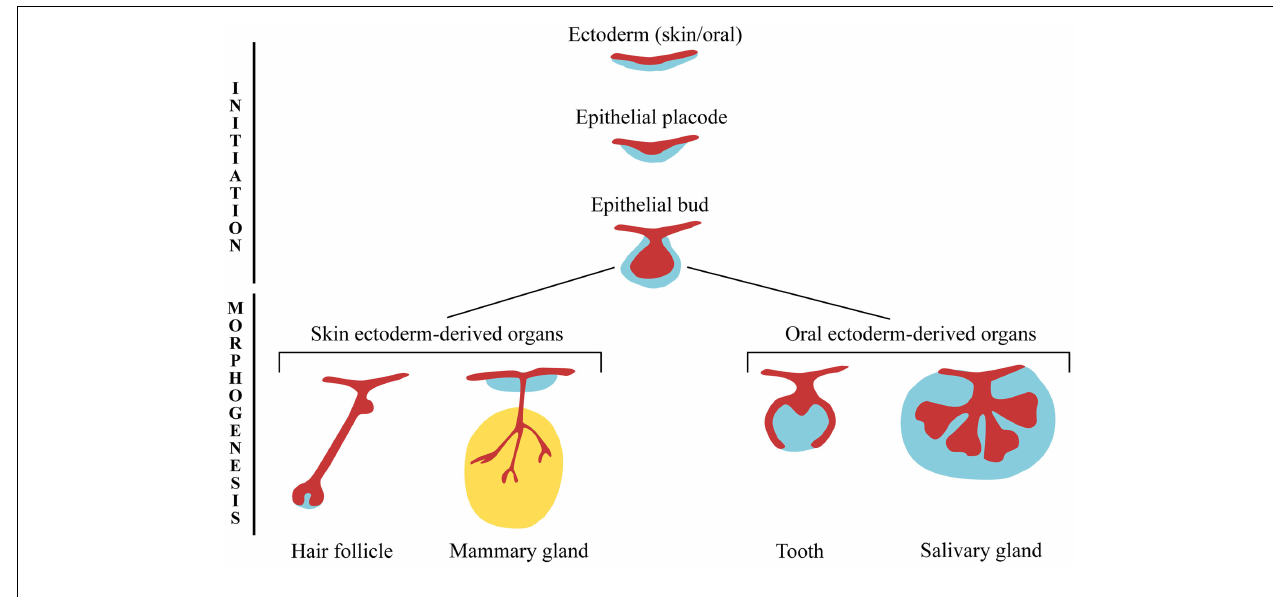
mesenchyme, is common to the early development of all ectodermal organs. At later developmental stages, epithelial buds undergo different morphogenetic programs resulting in the formation of highly specialized structures.